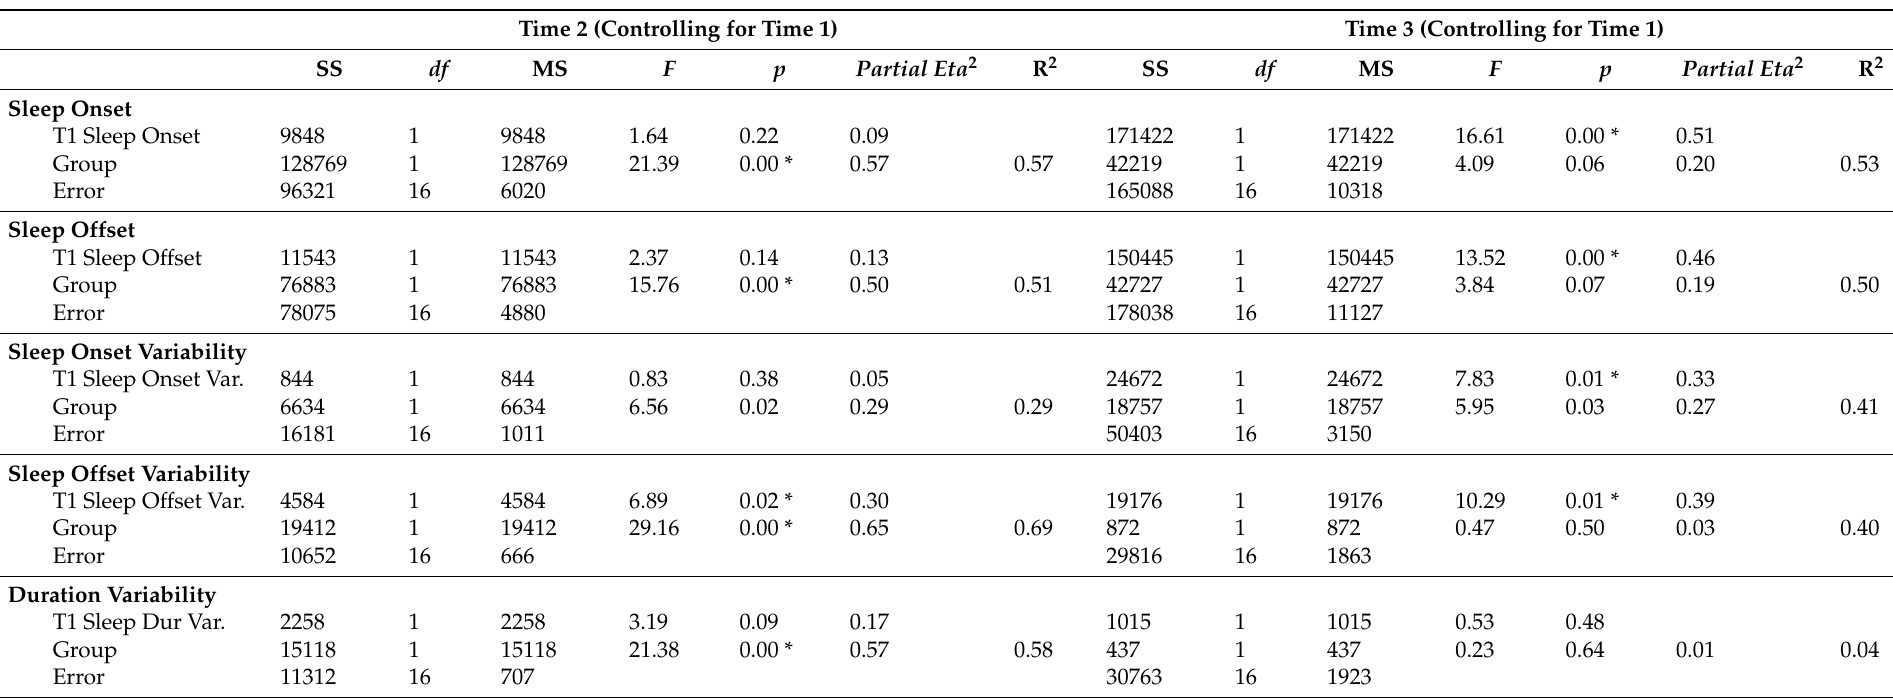
Table 4. Post-hoc follow ups comparing FIRST Patients to Comparison Group at Time 2 and Time 3, controlling for Time 1